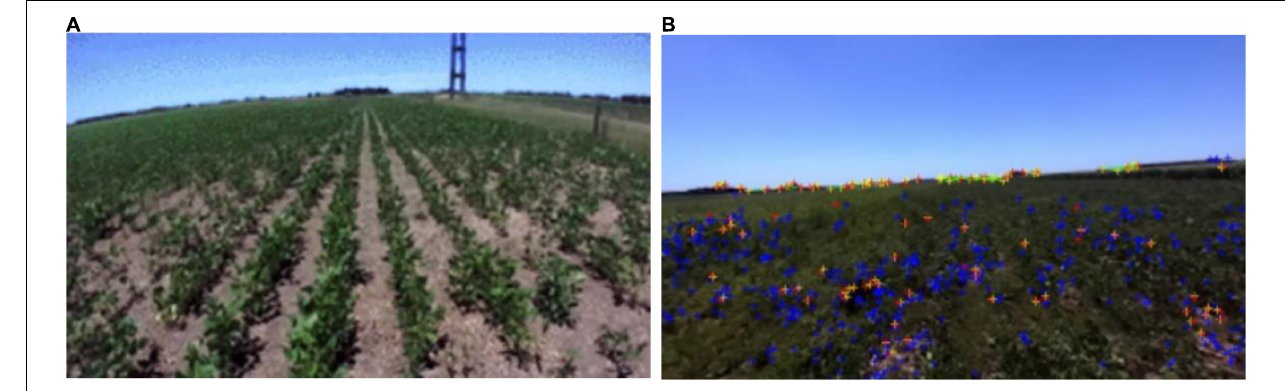
FIGURE 2 | (A) Data set–repeated scenes and (B) example of dataset tracking.